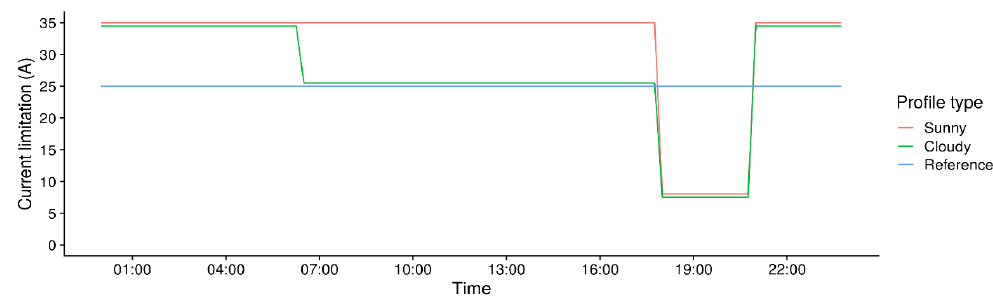
Figure 1. The time-dependent profile deployed on the selected Flexpower charging stations under sunny and cloudy conditions compared to the current limit per phase on a regular public charging station in Amsterdam.